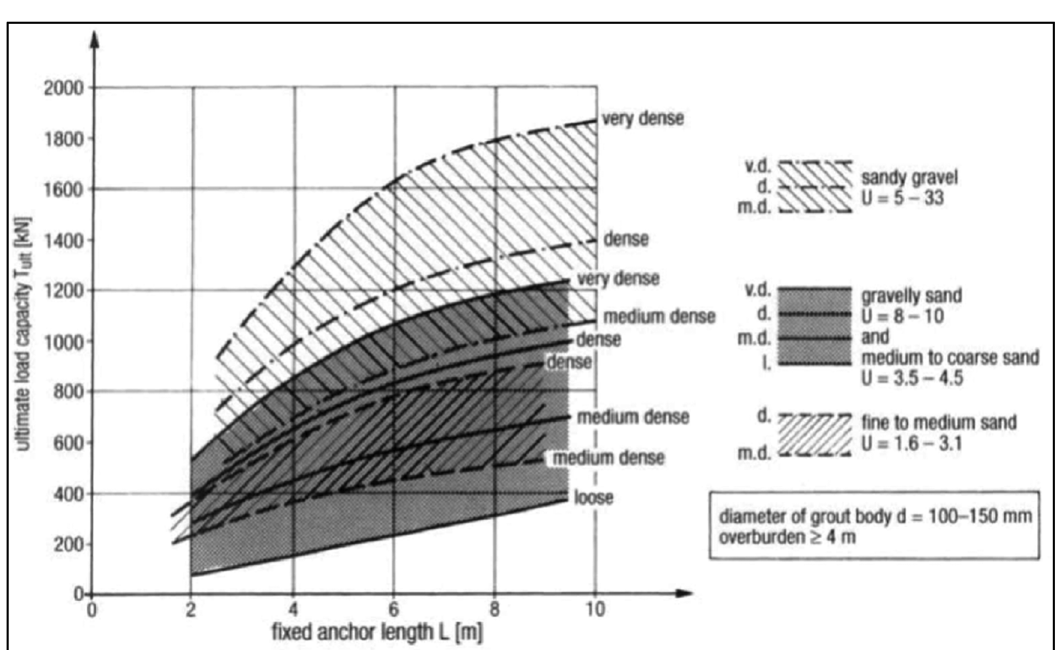
Figure 7: Carrying capacity of anchors in non - cohesive soils, after [ 8 ]